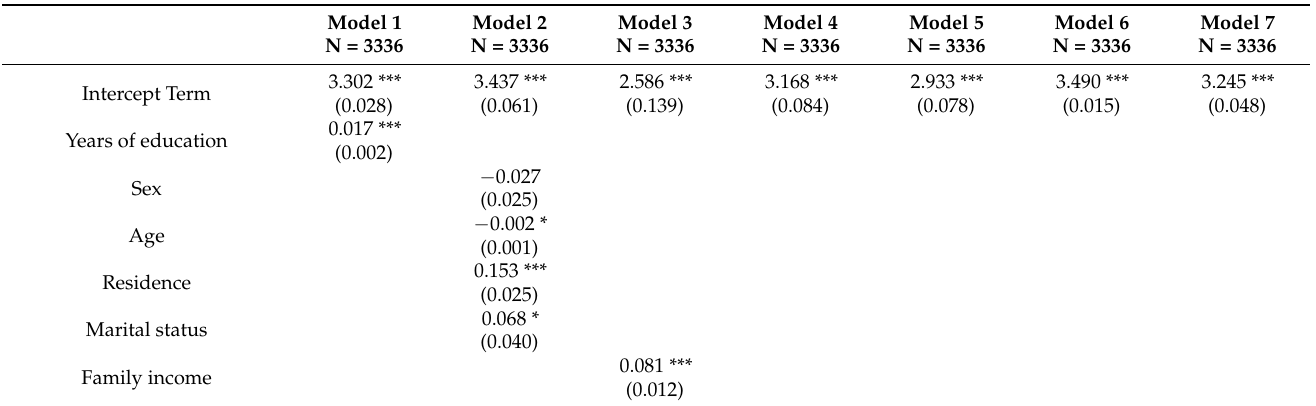
Table A6. Results for psychological